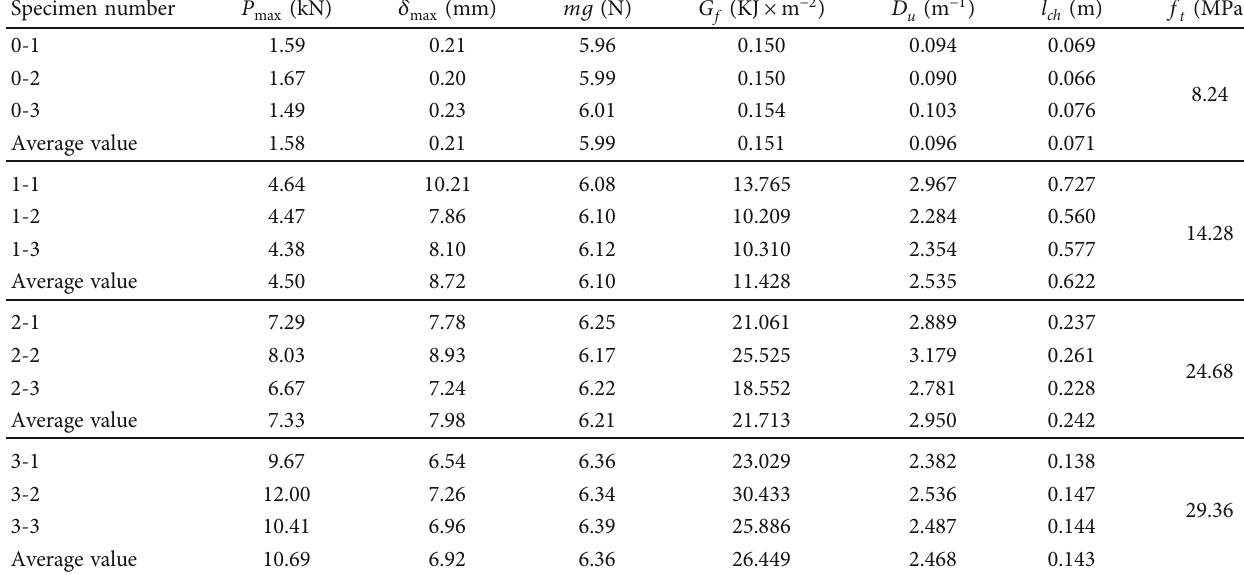
Table 3: Fracture energy and related indexes of reactive powder